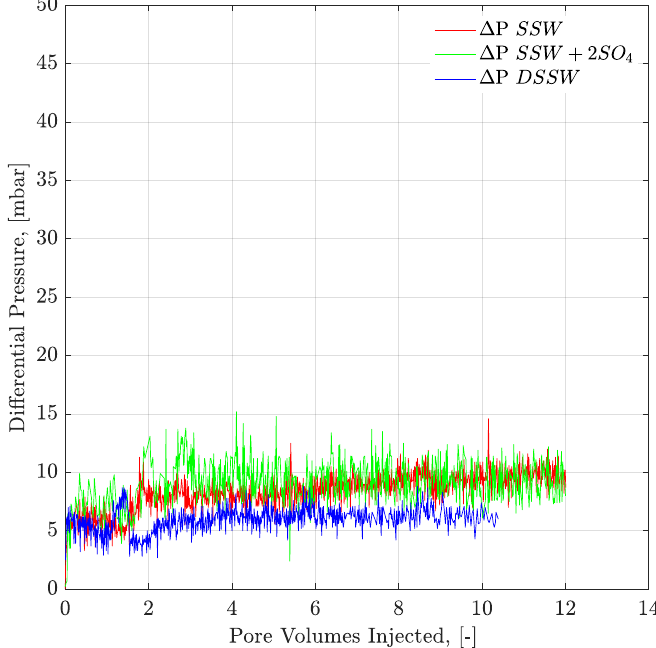
Figure 13. Pressure response of secondary mode brines flood through complex-wet micromodel at flux rate of 1 ft/day. ΔP SSW represents the pressure drop for synthetic seawater and ΔP SSW + 2SO 4 denotes the pressure drop for synthetic seawater with doubled amount of sulfate and ΔP DSSW represents the pressure drop for ten times diluted synthetic seawater.